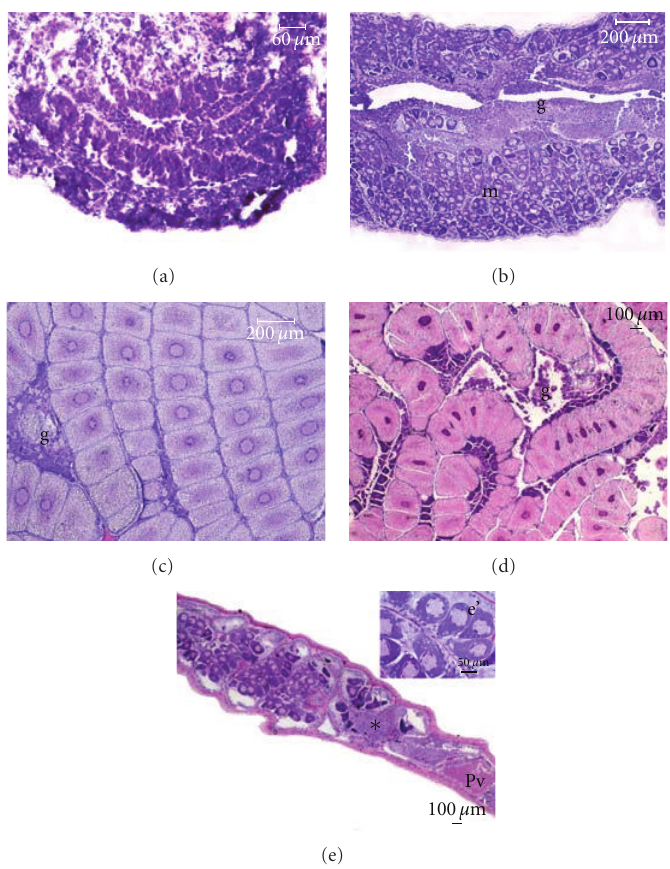
Figure 6: Ovarian maturity stages of Aristaeomorpha foliacea (haematoxylin-eosin). (a) Immature ovary (stage 1); (b) recovering ovary (stage 2b), showing distinct germinative (g) and maturative (m) zones, the latter populated by late primary oocytes organized into tubule- like structural units. (c) Maturing ovary (stage 2c) populated by early vitellogenic oocytes, among which small germinative islets (g) can be seen. (d) Mature ovary (stage 2d) populated by late vitellogenic oocytes creating a mosaic structure. g: germinative islets. (e) Spent ovary (stage 2e) containing a residual post-vitellogenic oocyte (Pv), besides degenerating late primary oocytes displaying severe vacuolization of the cytoplasm (e’). Proliferation and hypertrophy of mesodermal cells (asterisk) are also evident. (i.e., GRUND, Valutazione delle Risorse Demersali, and MEDITS, International Bottom Trawl Survey in the Mediter- ranean